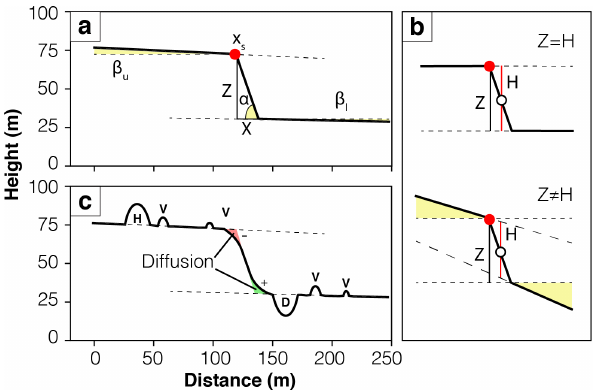
Figure 3. An example of a synthetic catalogue fault scarp. (a) Vi- sual description of the parameters in Table 1 used in the syn- thetic catalogue without non-tectonic features. (b) The difference between vertical displacement Z and synthetic profile scarp height H g , resulting from sloping original surfaces. (c) The additional non- tectonic synthetic catalogue parameters ( H indicates hills; V indi- cates vegetation; D indicates ditches) and diffusion (red indicates erosion; green indicates